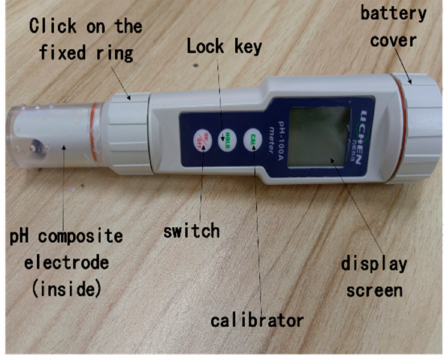
Figure 2. pH-100 A pen-type pH meter.